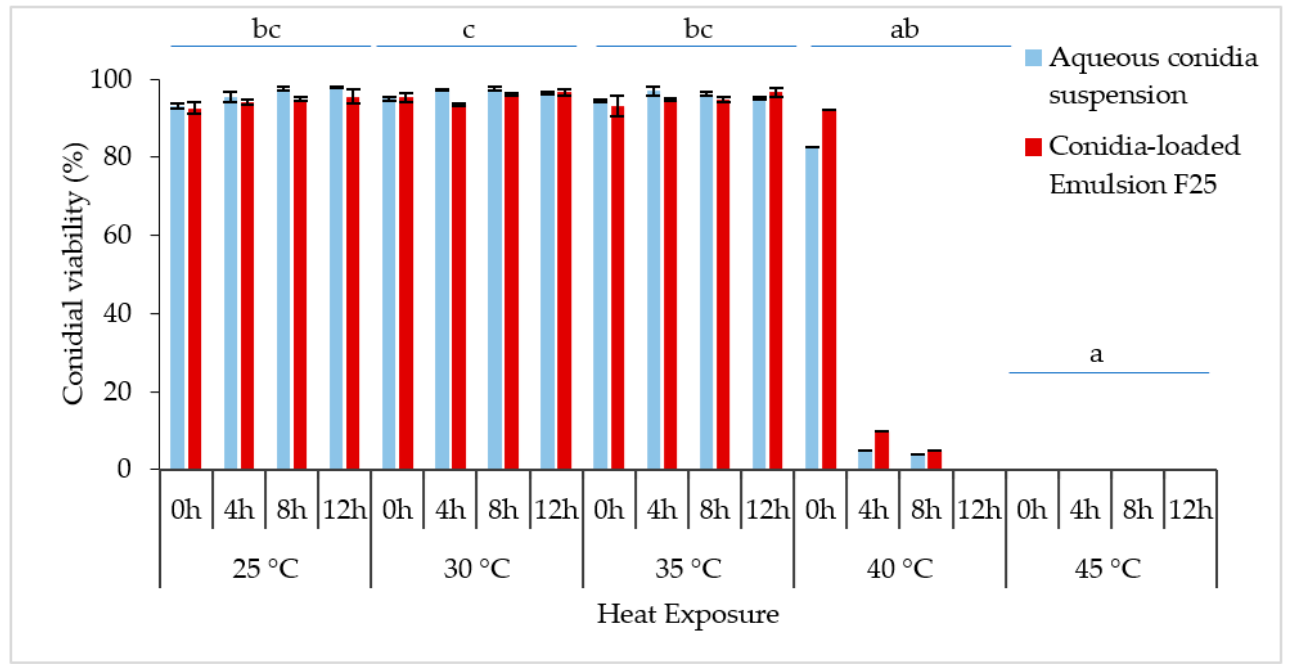
Figure 8. Conidial germination of M. anisopliae spores at 25 °C at different times; ( A ) 0 h, ( B ) 4 h, ( C ) 8 h, and ( D ) 12 h at microscopic magnification of 400×.